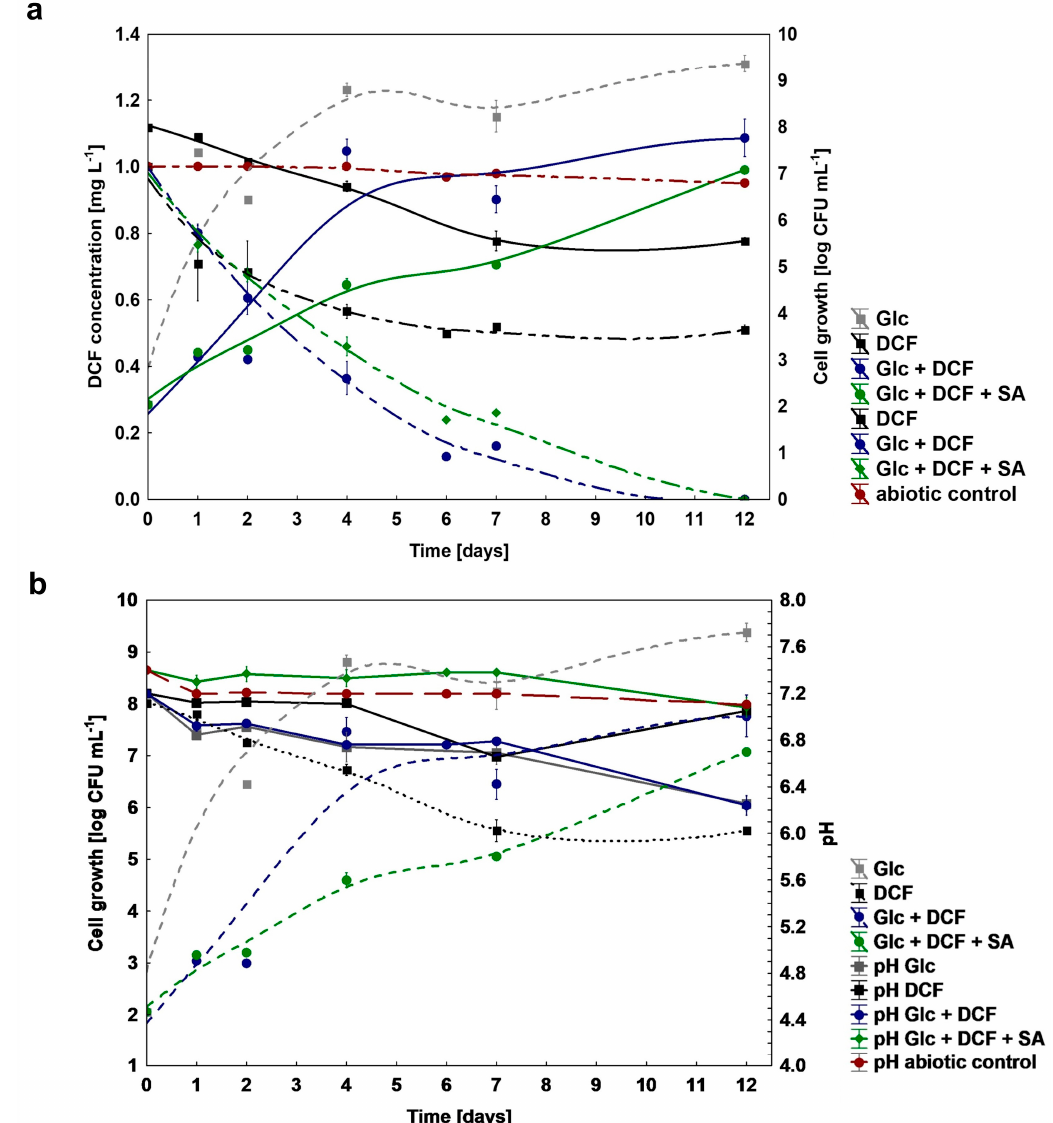
Figure 1. ( a ) Changes in cell growth (log CFU mL − 1 ) and degradation of DCF under mono-substrate and co-metabolic conditions; ( b ) changes in the pH during DCF degradation. DCF—diclofenac, Glc—glucose, SA—sodium acetate.